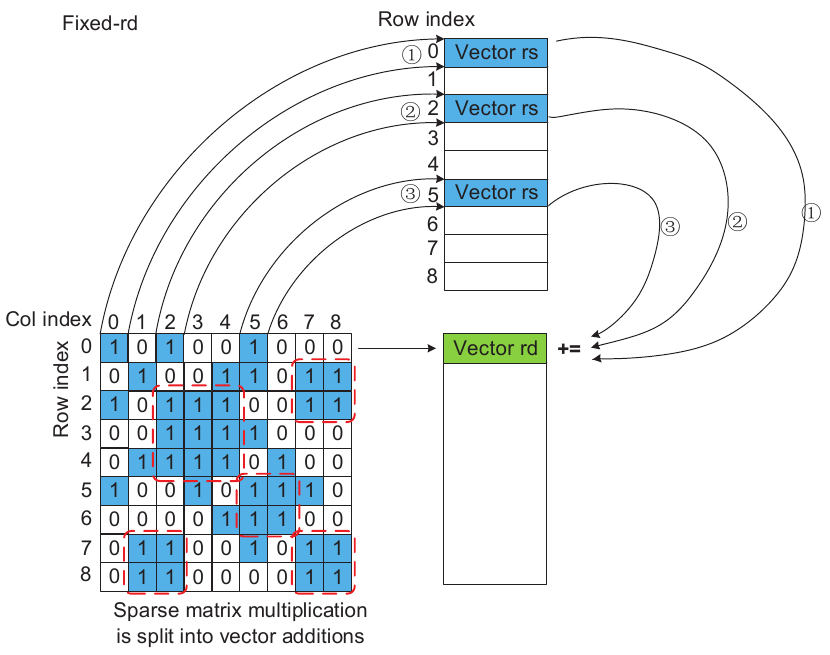
Figure 24. The redundant computations in GCNs. The numbers in circle indicate the computation